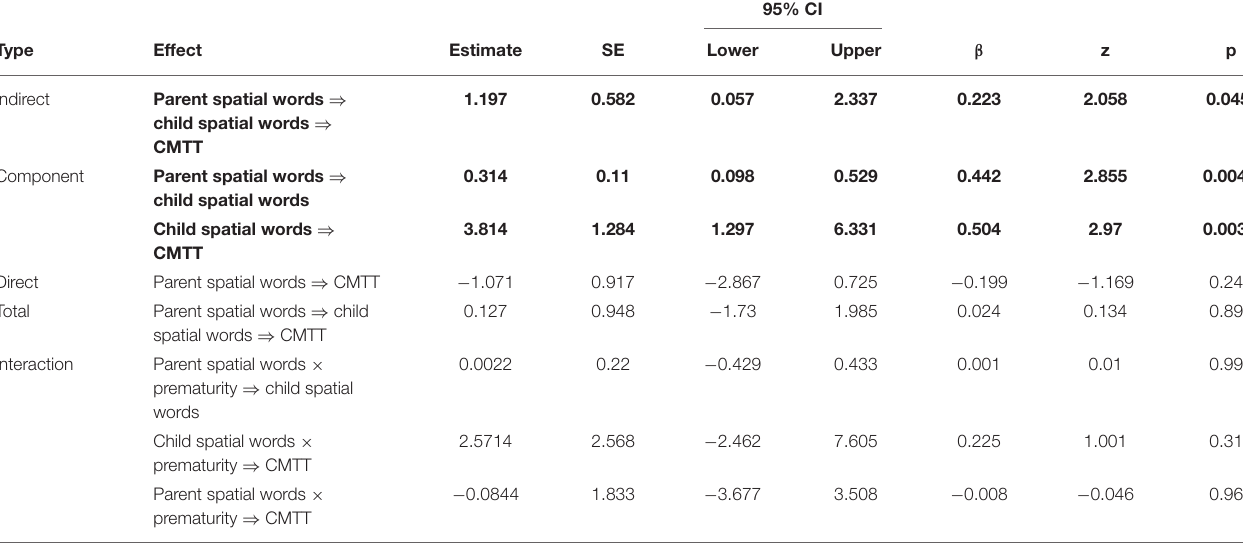
TABLE 6 | Moderated mediation models for spatial language: effects that are statistically significant are written in